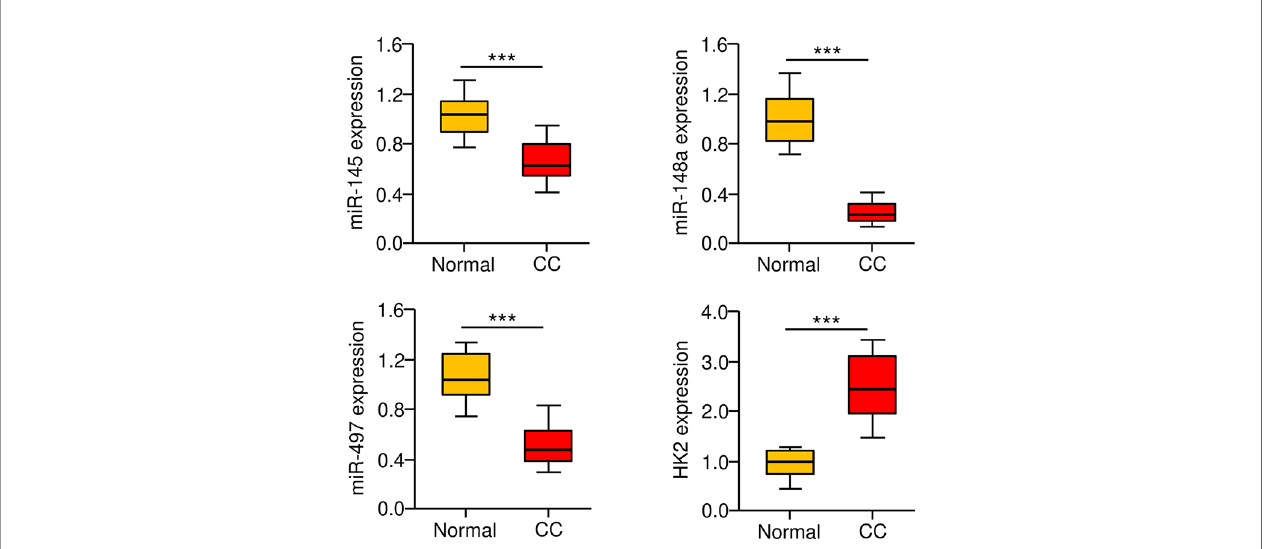
FIGURE 7 | Correlation between MiR-145/148a/497 and HK2 Expression in CC Tissues. The expression of miR-145, miR-148a, and miR-497 in CC and adjacent normal tissues was measured using the qRT-PCR assays. *** P <